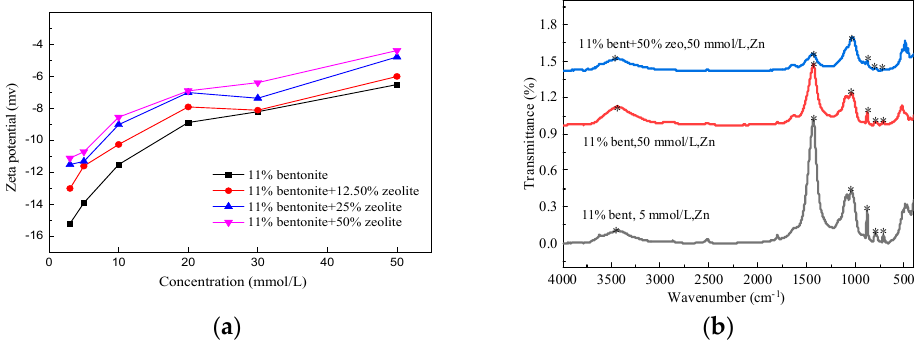
Figure 12. Microscopic changes in adsorption tests under different conditions. ( a ) change of zeta potential; ( b ) FTIR spectra.